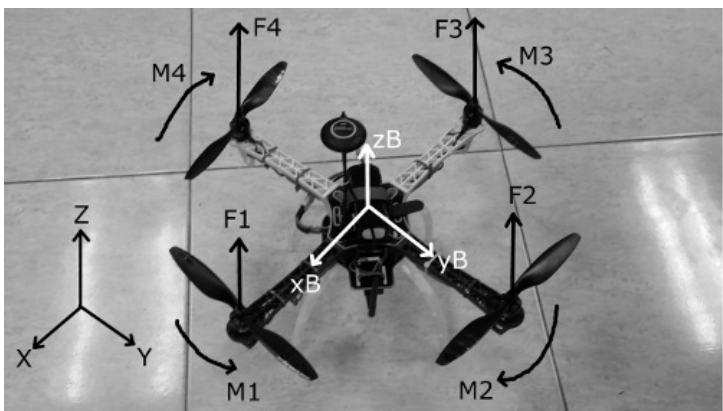
Figure 1. Coordinate Systems and moment/forces acting on the